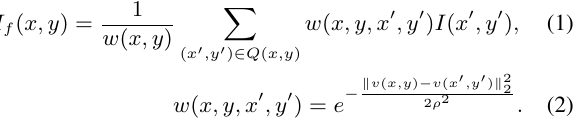
Figure 1. Hermite functions (a) and Gaussian function derivatives